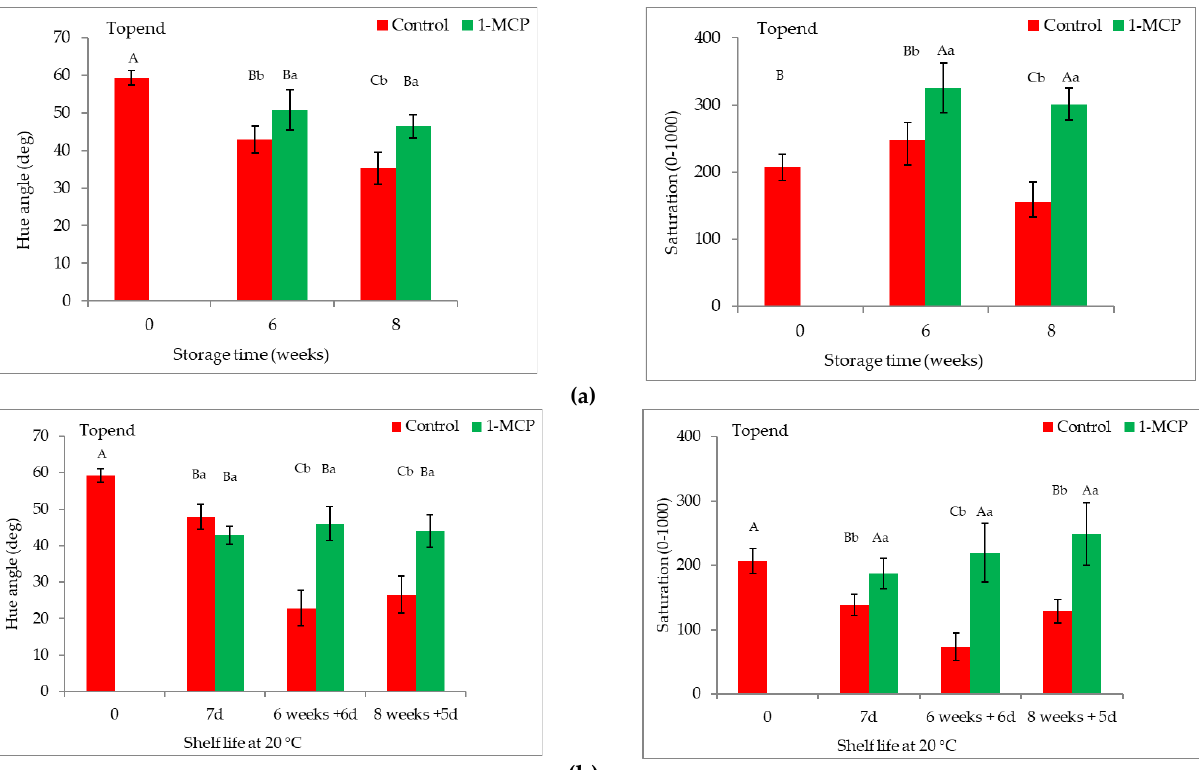
Significant values are marked as + p < 0.05, * p < 0.01.